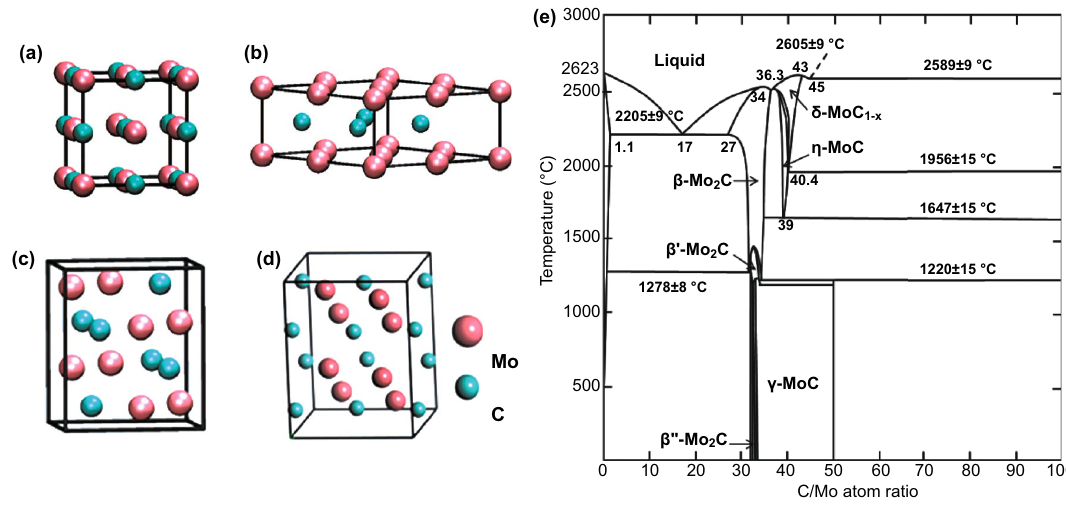
Fig. 4 Bulk crystallographic structures of Mo-based TMCs. a fcc α-MoC 1−x , b hexagonal γ-MoC and η-MoC, c orthorhombic β-Mo 2 C, d orthorhombic α-Mo 2 C. Reproduced with permission from Ref. [36]. Copyright 2018, Elsevier. e Phase diagram of C-Mo system. Reproduced with permission from Ref. [39]. Copyright 2001, American Physical